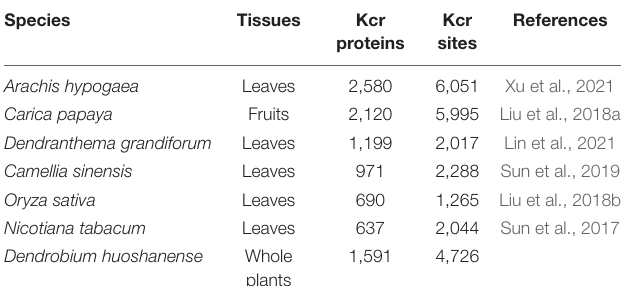
TABLE 1 | The number of crotonylated proteins and sites identified of Dendrobium huoshanense compared with previous studies of plants. Species Tissues Kcr